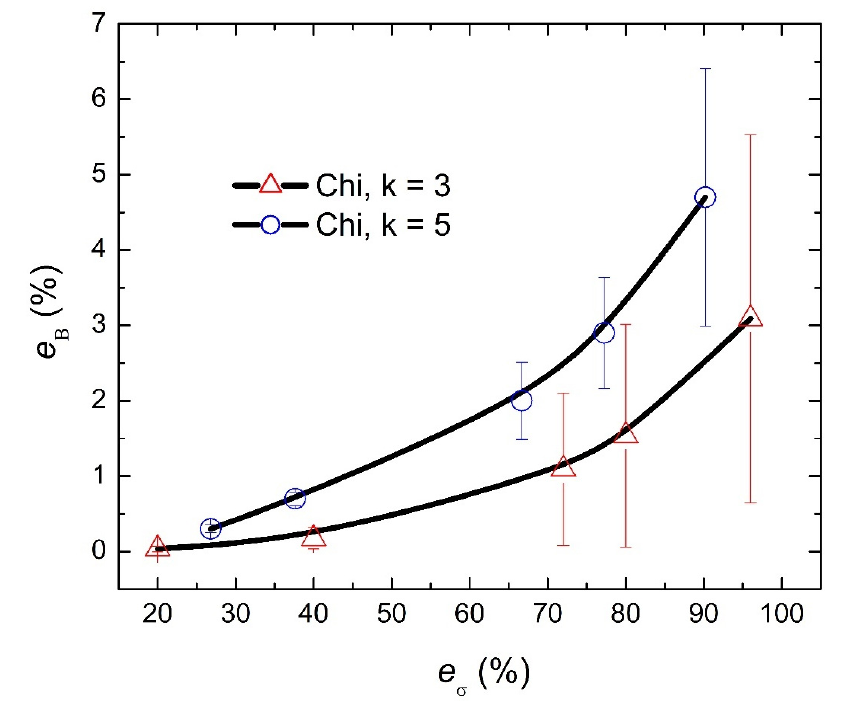
Figure 1. Relative error in the calculation of B as a function of the dispersion of the standard deviations of the Gaussian components (for k = 3, 5). The points in the plot have been connected by means of reproducing kernel Hilbert space (RKHS) interpolations [20,21].